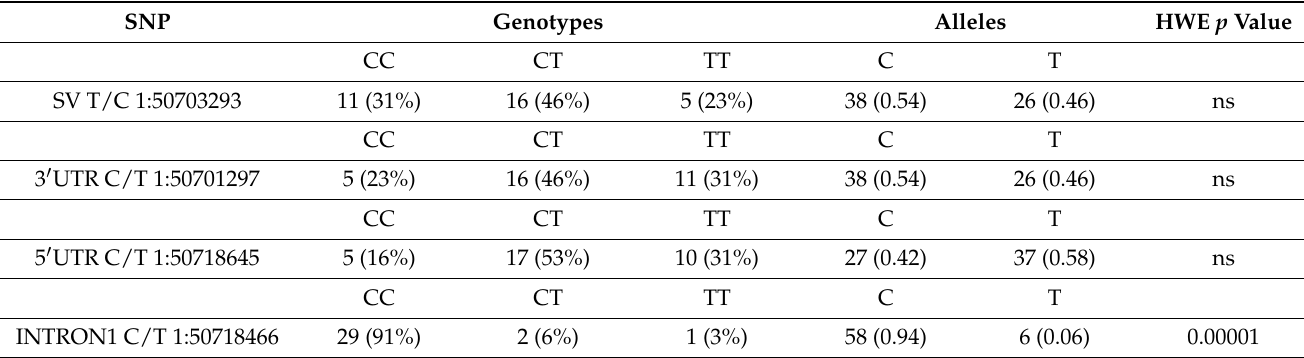
Table 4. The genotype distribution for SNPs detected in TLR7 gene.